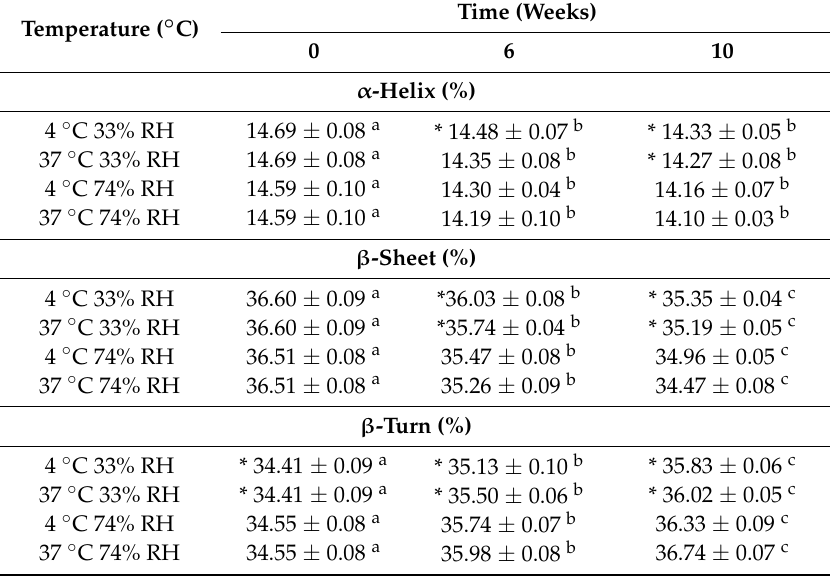
Table 2. Secondary structure compositions of PPI under different relative